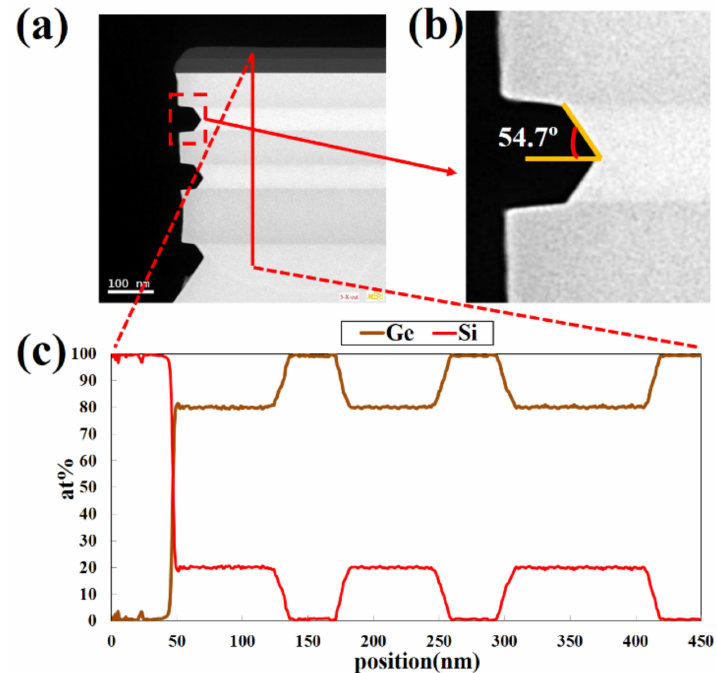
Figure 7. ( a , b ) TEM images of etching profile, and ( c ) EDS analysis with line scanning of Si and Ge in vertical orientation of the Ge buffer/p + -Ge 0.8 Si 0.2 /Ge stack structure. The selective etching of Ge at (111) planes results in a lateral angle of 54.7 ◦ . (20 cycles; temperature of HNO 3 = 15 ◦ C; oxidation time t ox = 30